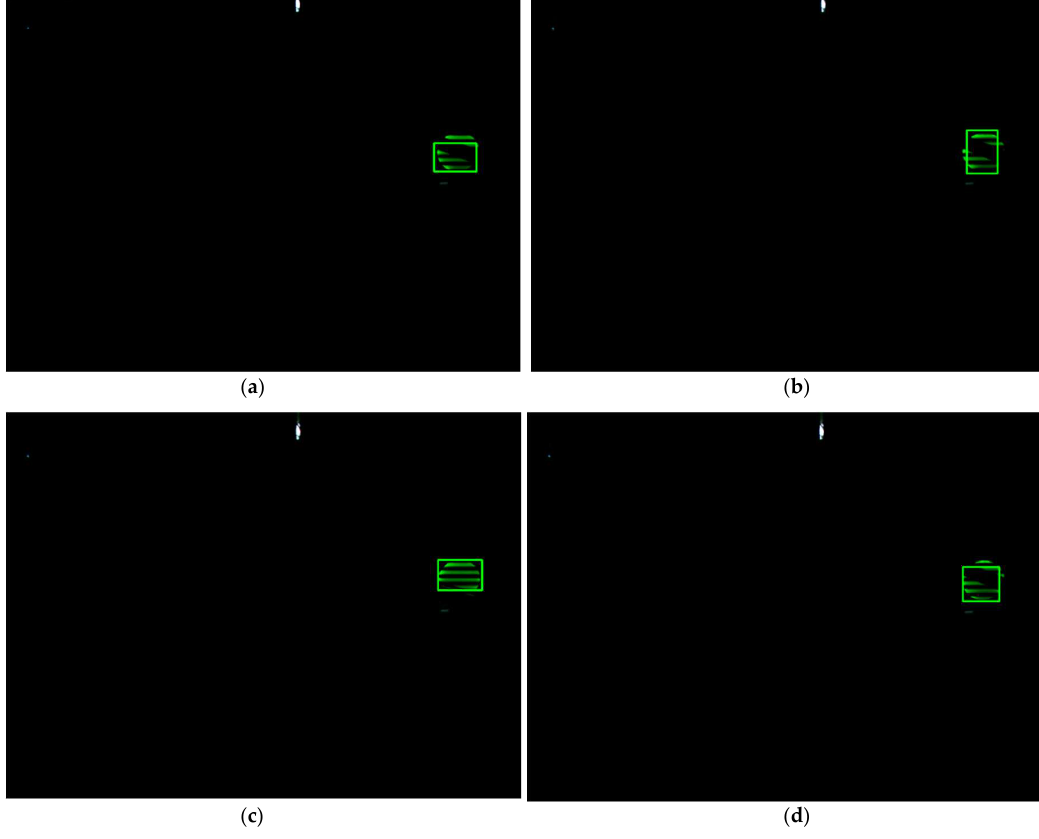
Figure 12. Tracking performance of the proposed algorithm when occlusion occurs: ( a ) frame number: 14, ( b ) frame number 21, ( c ) frame number 34, and ( d ) frame number 47.